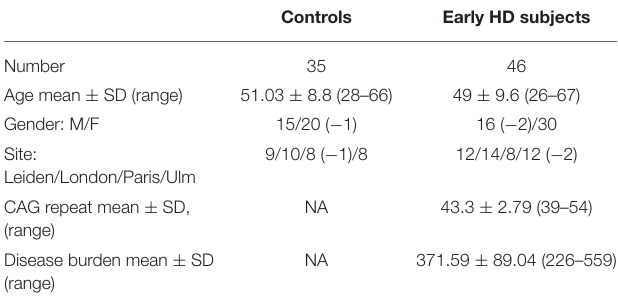
TABLE 1 | Participant